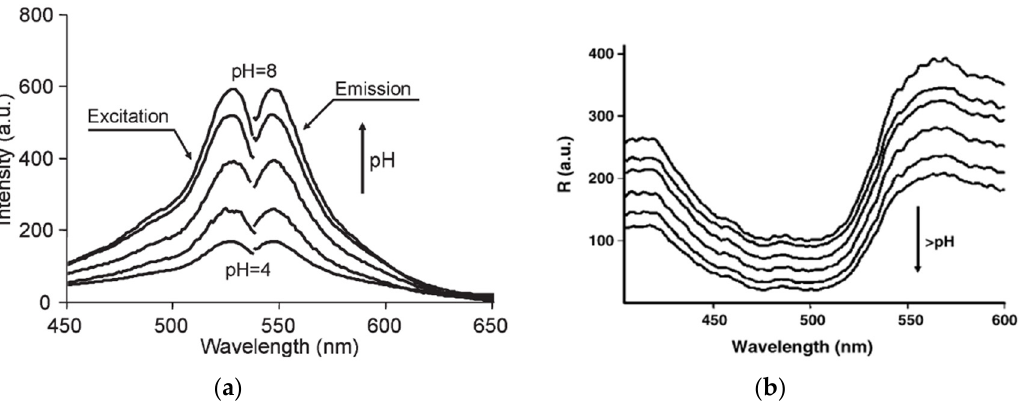
Figure 14. ( a ) Excitation and emission spectra of the sensing phase as a function of pH. ( b ) Reflectance spectra of the sensing phase as a function of pH.